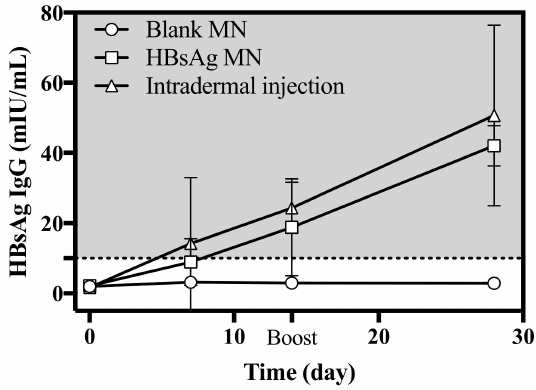
Figure 8. Serum HBsAg IgG level after the intradermal injection of HBsAg, application of blank and HBsAg MN ( n = 4). Boost vaccination was carried out on day 14. Dashed line represents the marker of adequate immunity ( > 10 mIU / mL).